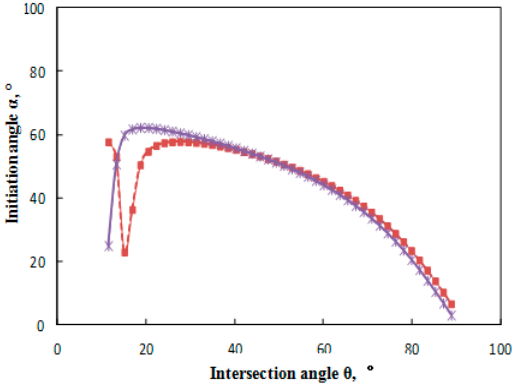
Figure 9 . The impacts of relative position of the fracture on the initiation angle. Figure 9. The impacts of relative position of the fracture on the initiation angle. Energies 2018 , 11 , x FOR PEER REVIEW